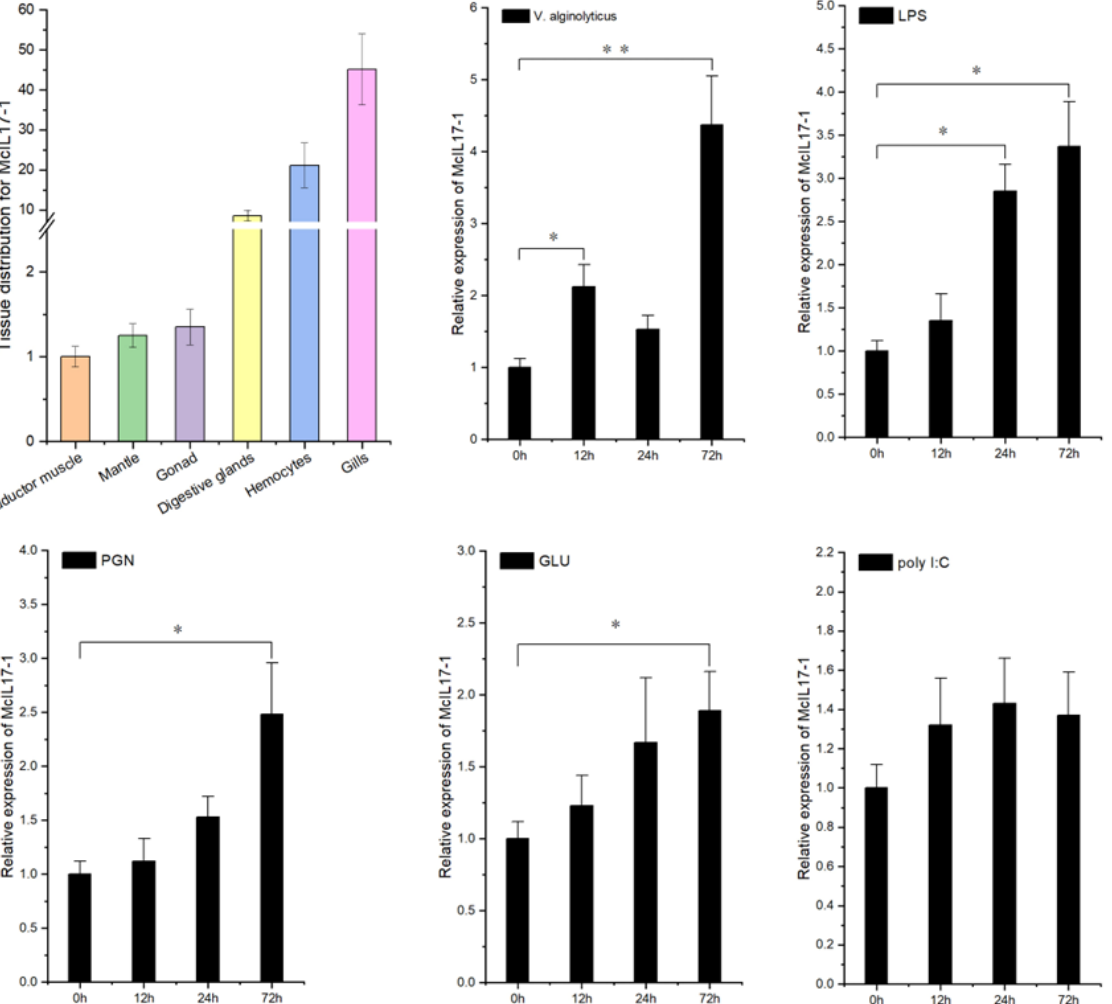
Figure 3. Expression profile analysis of Mc IL17-1 transcripts in common adult tissues and after chal- lenge with live V. alginolyticus , lipopolysaccharide (LPS) (from Escherichia coli O111: B4), peptidogly- cans (PGN) (from Staphylococcus aureus ), glucan (GLU) (from Saccharomyces cerevisiae ), or polyinosinic-polycytidylic acid (poly I:C), respectively. The results were expressed as mean ± S.D. (n = 3). Significant difference relative to control is indicated with asterisk symbol (* p < 0.05, ** p < 0.01).